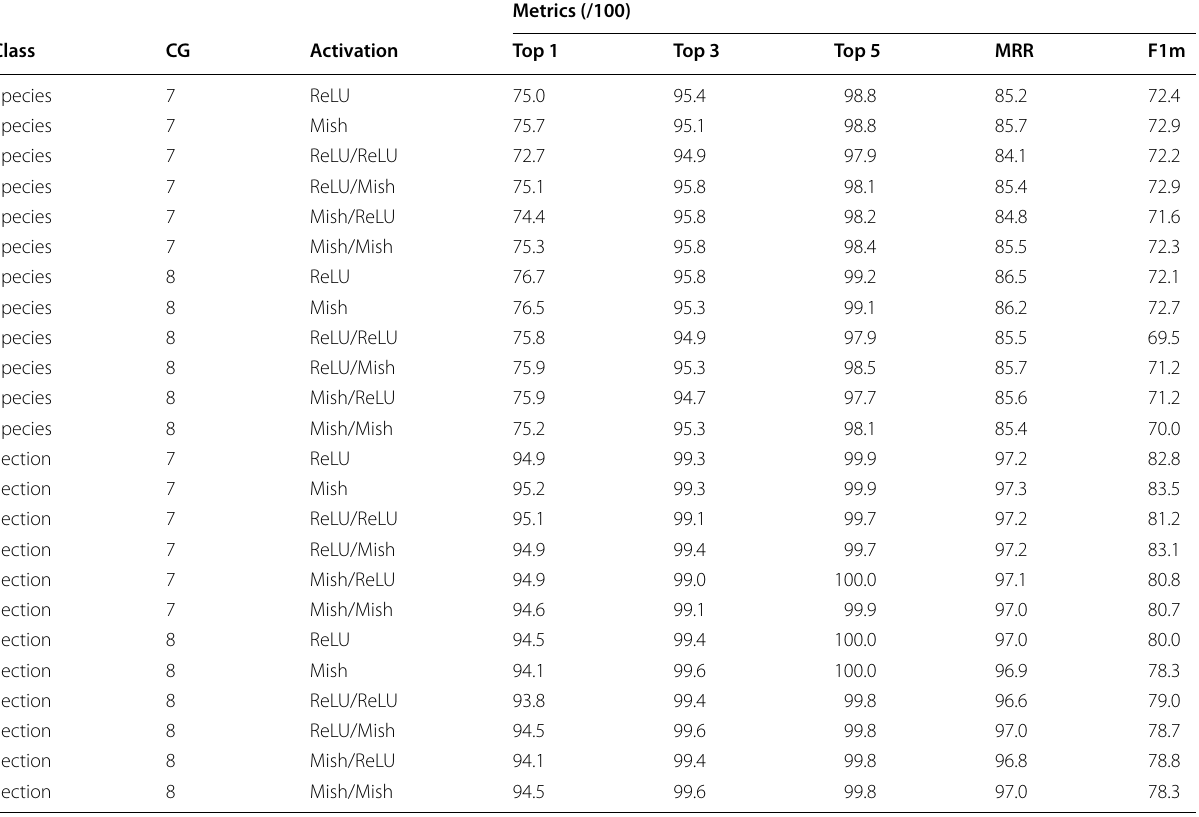
Table 9 Summary of results for identifiers with different neural network shapes and activation functions Metrics